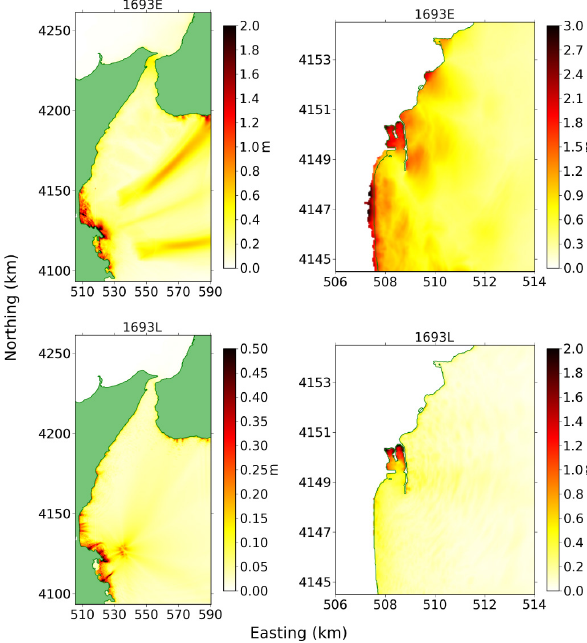
Fig. 9. Maximum water elevation for 1693 E and 1693 L scenarios (left column) and their corresponding detailed maximum inundation in Catania (right